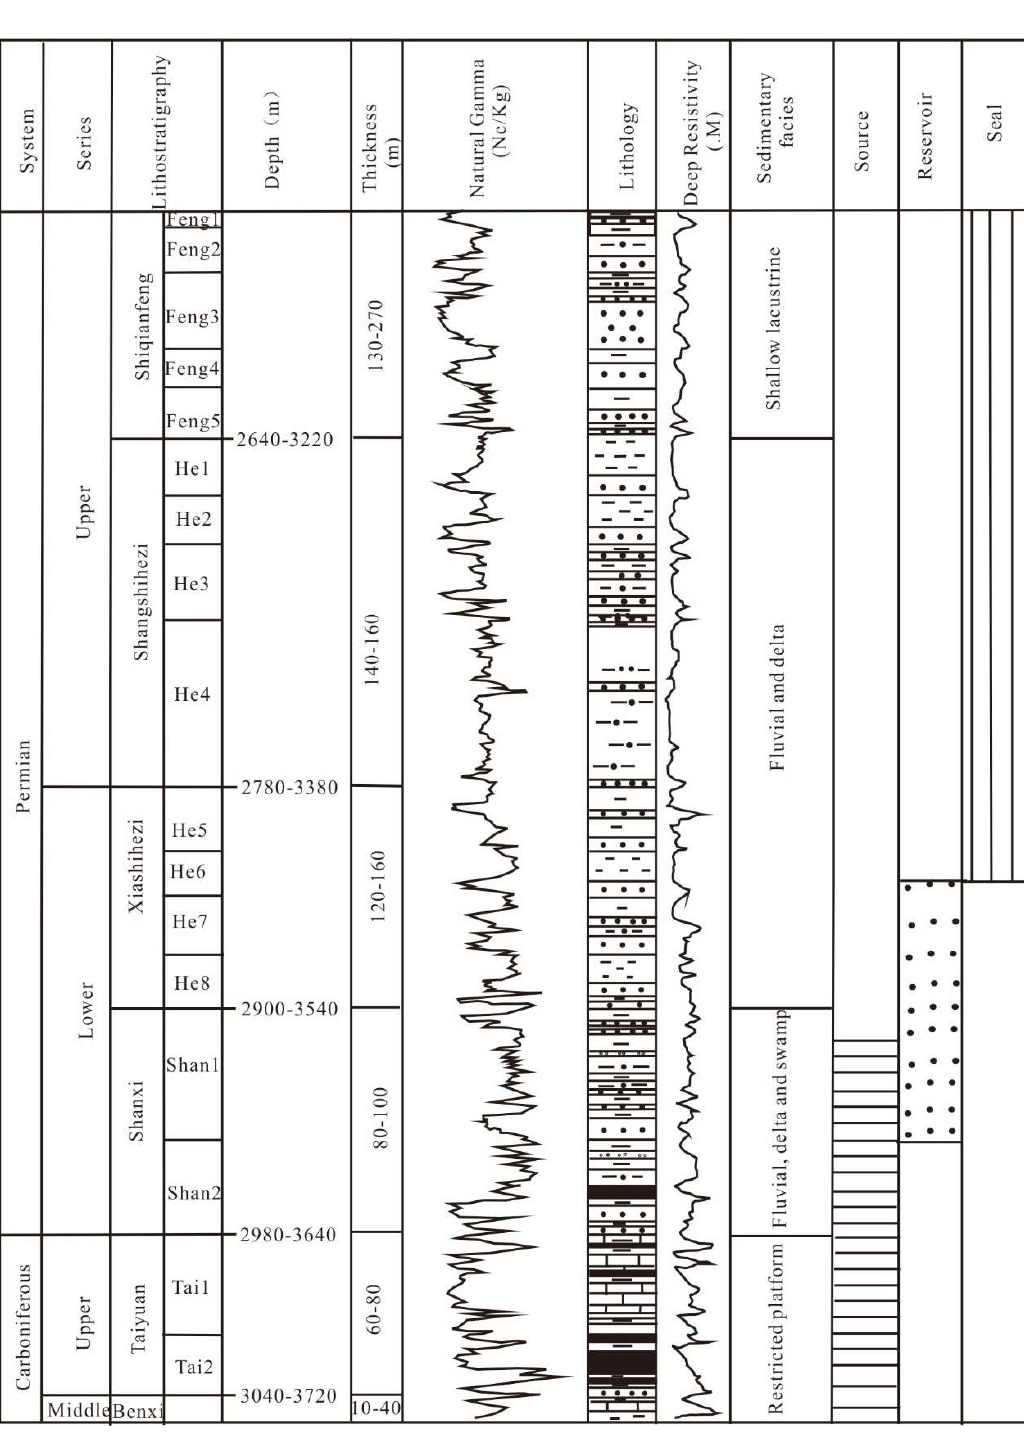
Figure 2. Generalized stratigraphic Upper Paleozoic column in Sulige gas field. (modified from references [9,11,12]).